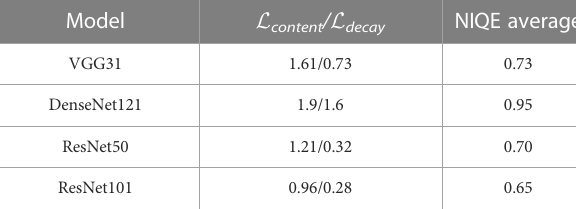
TABLE 2 The Comparison of results from different encoders.